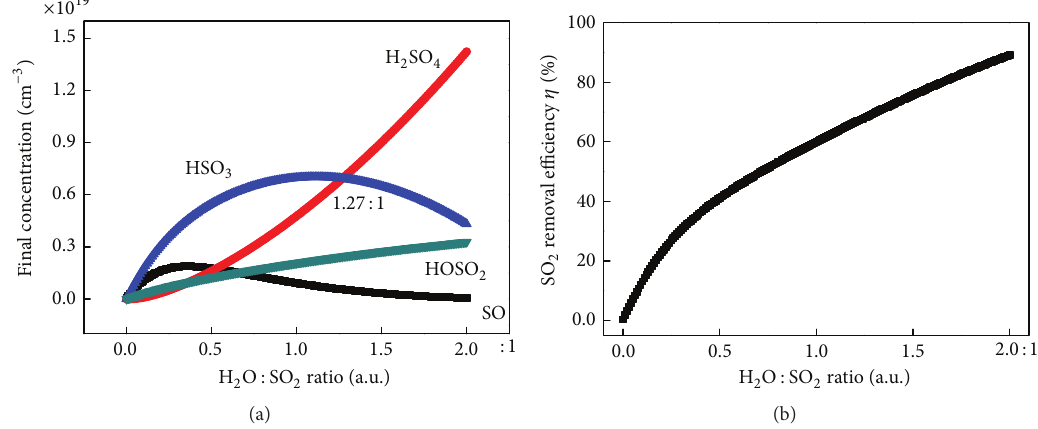
Figure 8: Under different initial vapor additive ratio, (a) the final concentration of H 2 SO 4 , HSO 3 , HOSO 2 , and SO and (b) the SO 2 removal efficiency after discharge lasted for 0.5 𝜇